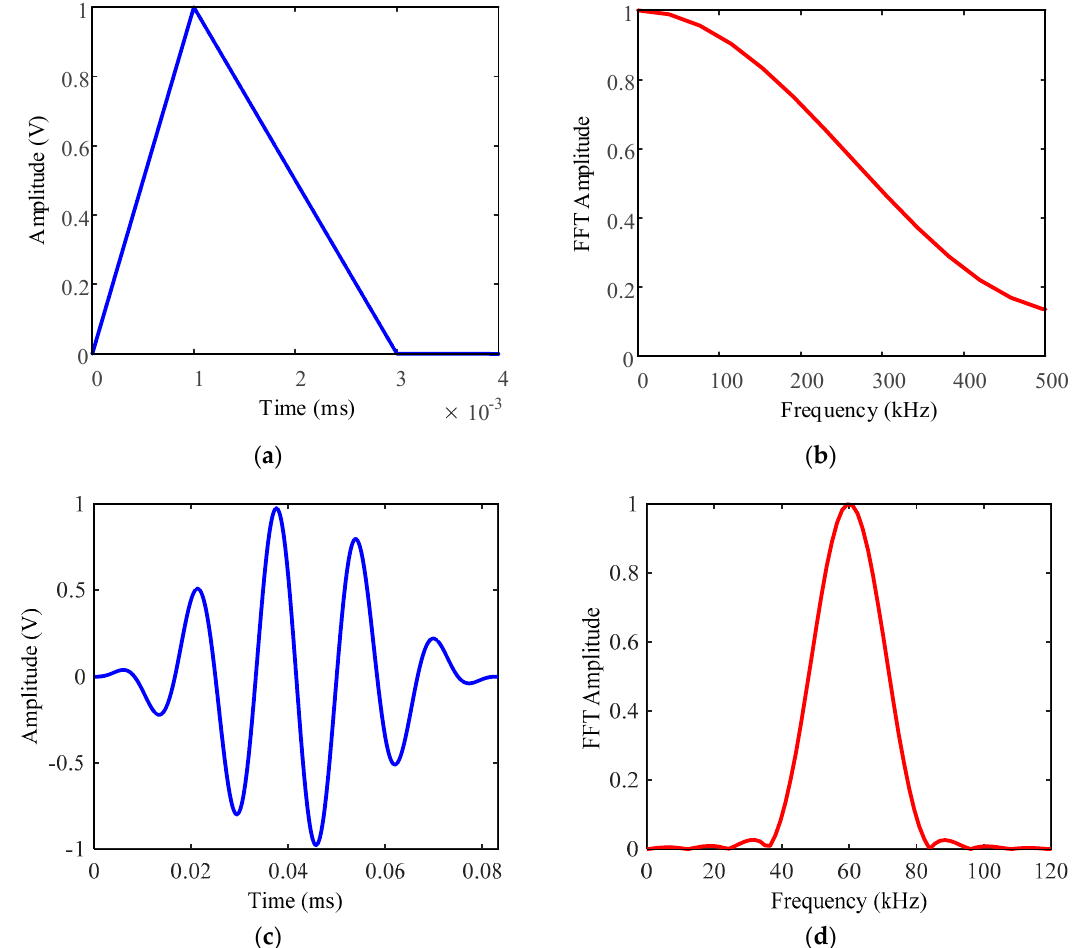
Figure 5. The excitation signal and fast Fourier transform (FFT) spectrum: the triangular pulse with a broadband of 500 kHz in the ( a ) time domain and ( b ) frequency domain; the Hann-windowed, five-cycle, 60 kHz sinusoidal tone burst in the ( c ) time domain signal and ( d ) frequency domain.